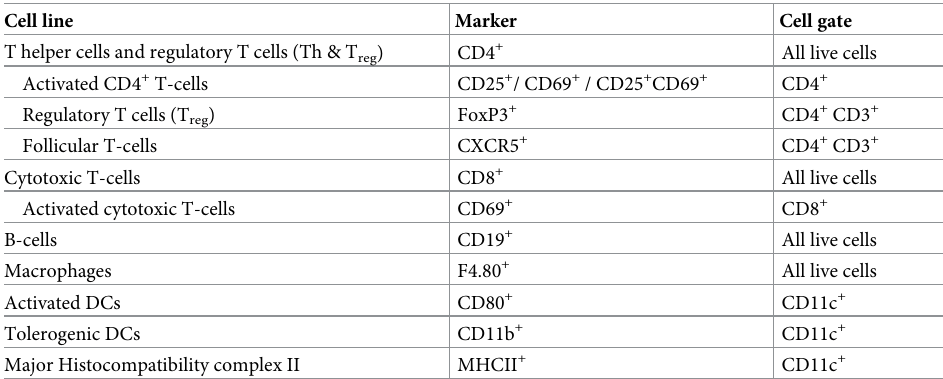
Table 1. Markers and gates for flow cytometry. List of cell subsets investigated with fluorescence-activated cell sort- ing (FACS), as well as the marker used and gate from which it is defined, on cells extracted from mesenteric lymph nodes and spleen, from female BALB/c mice euthanized one week after a single injection of a tetanus